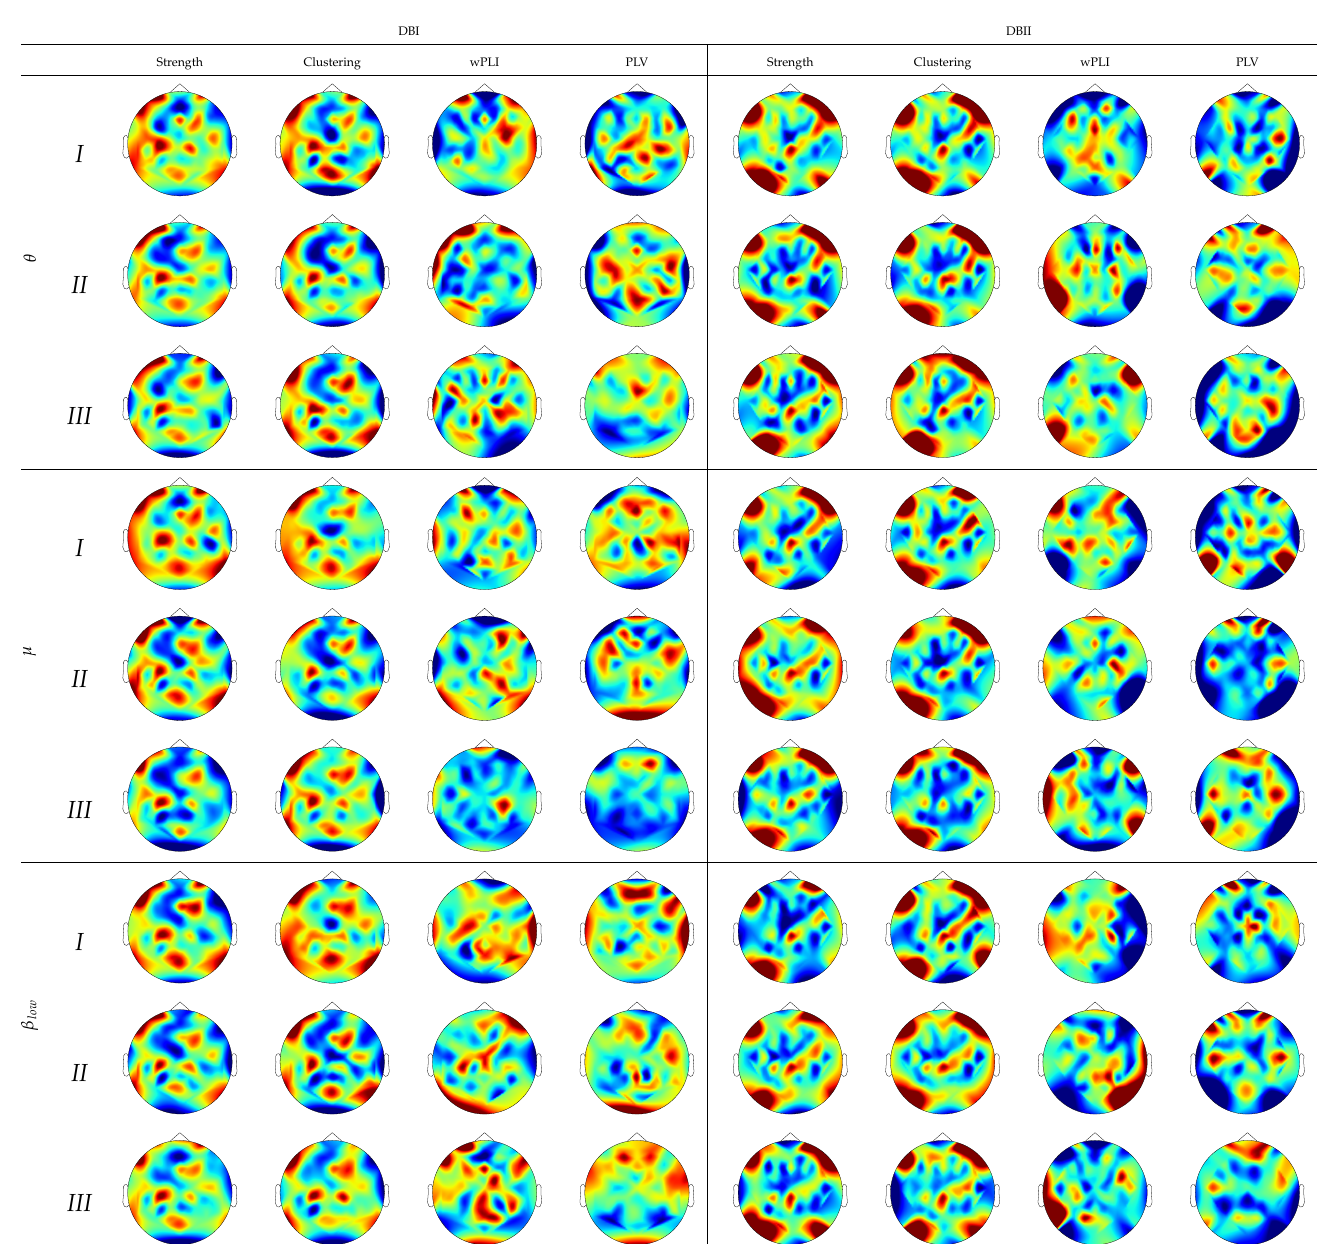
Figure 6. Topograms depicting the DNR weights performed by each inefficiency subject partition using FC predictors